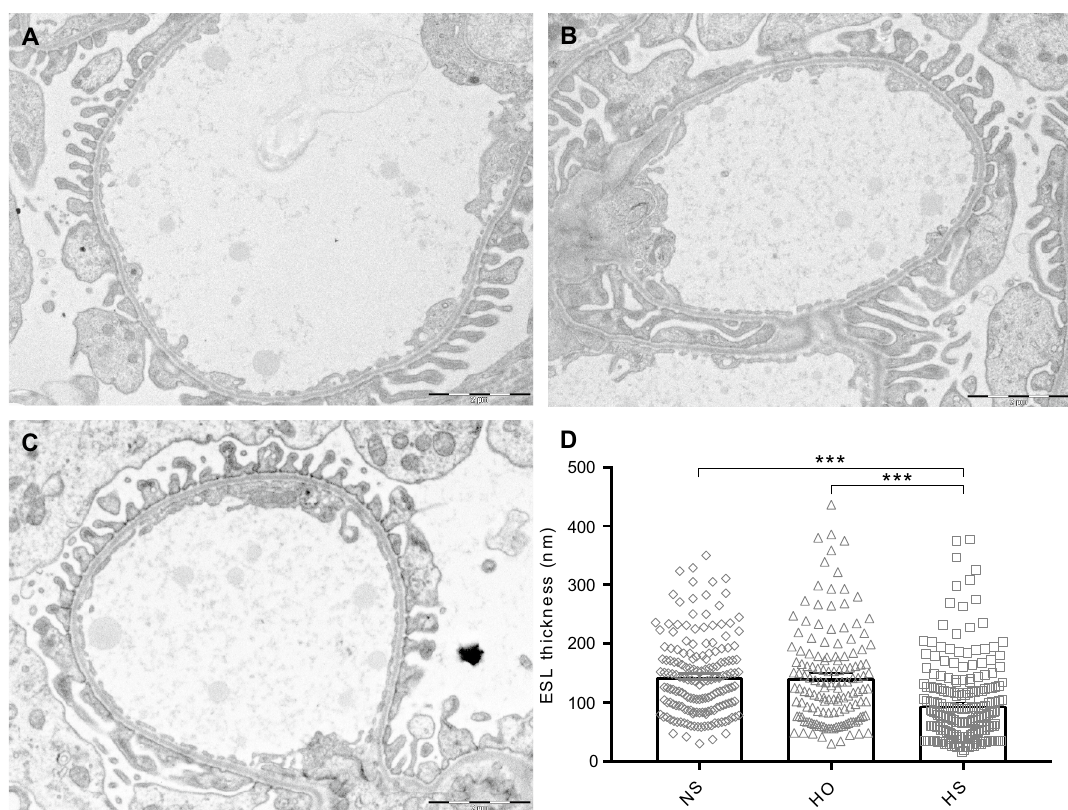
Figure 1. Glomerular morphology and endothelial surface layer thickness 10 min after perfusion. Representative pictures of glomerular capillaries from a rat perfused with physiological salt (NS) ( A ), high osmolarity (HO) ( B ) and high salt (HS) solution ( C ). The thickness of the ESL was estimated by measuring the distance between infused intralipid droplets and the endothelial cells. ESL thickness was reduced in the rats perfused with HS ( D ). Scale bar represents 2 µm. ***P < 0.001, error bars represent